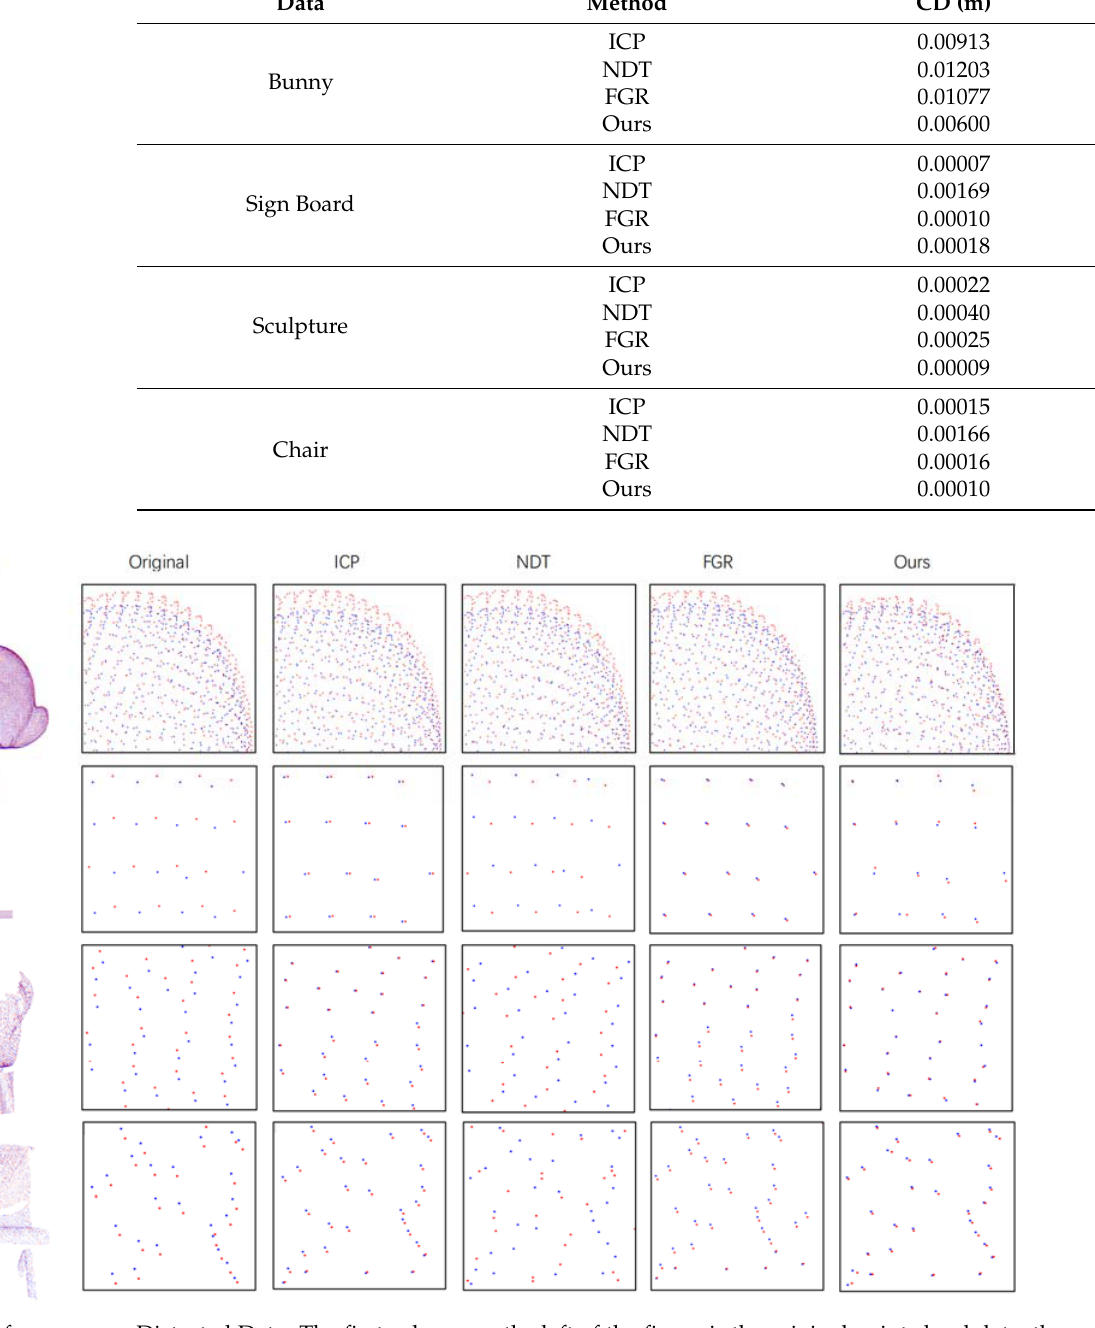
Figure 11. Performance on Distorted Data. The first column on the left of the figure is the original point cloud data, the second column is the detailed schematic diagram and the rest are the detailed diagrams after registration by each method.